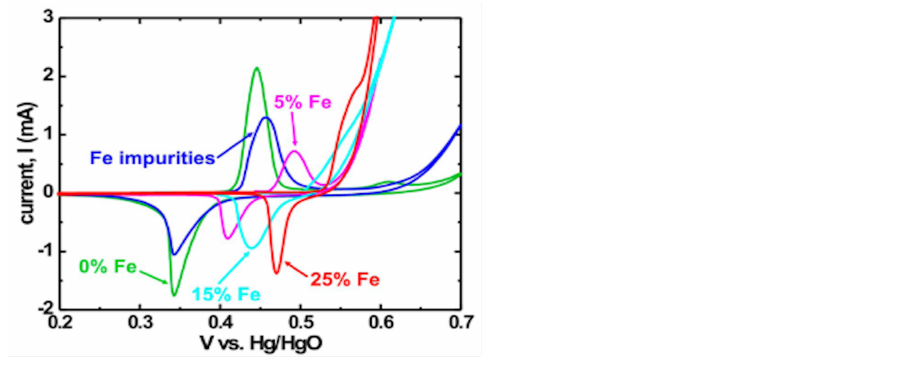
Figure 14. Cyclic voltammograms of Ni 1 − x Fe x (OH) 2 /Ni 1 − x Fe x OOH films. Retrieved from